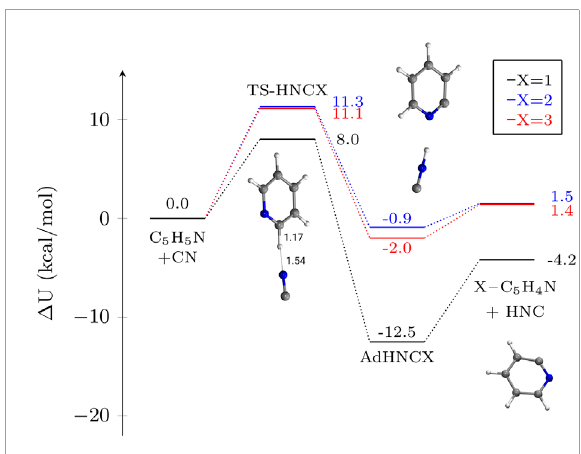
FIGURE 5 Potential energy profiles for the formation of HNC and X-pyridil ( X – C 5 H 4 N ) from pyridine and CN via a H abstraction in different atomic positions. The depicted magnitude is Δ U (electronic energy + ZPVE) in kcal mol −1 . Molecular structures of the stationary points on the different PES other than pyridine are shown for X = 1 as an example. Distances are given in Å.